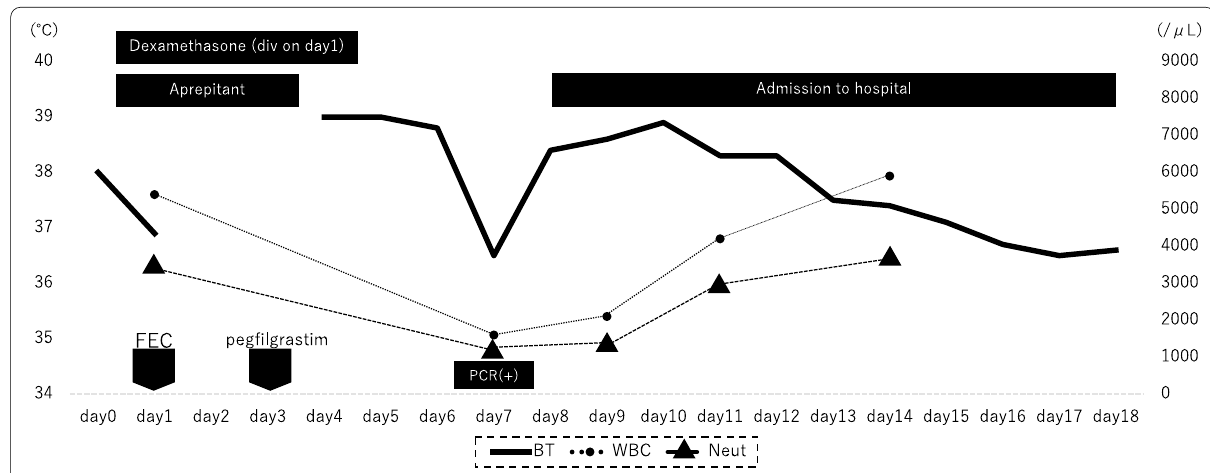
Fig. 3 Timeline before and after COVID-19 diagnosis. BT body temperature, WBC white blood cell count, neutro neutrophil count, FEC 5-fluorouracil, epirubicin hydrochloride, and